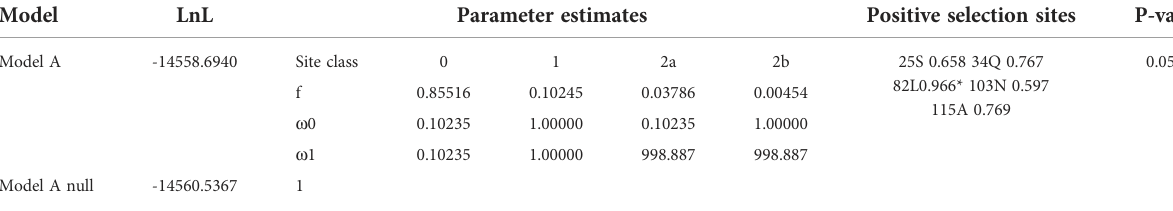
LnL, log-likelihood